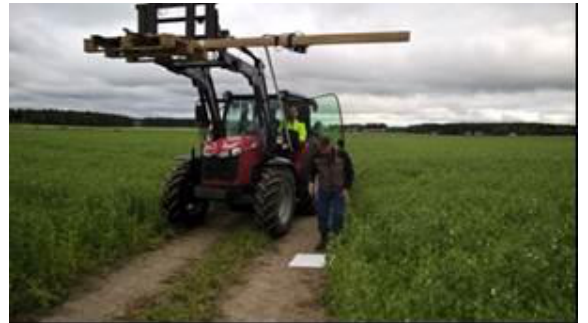
Figure 7 DroneKnowledge VIS-VNIR-SWIR